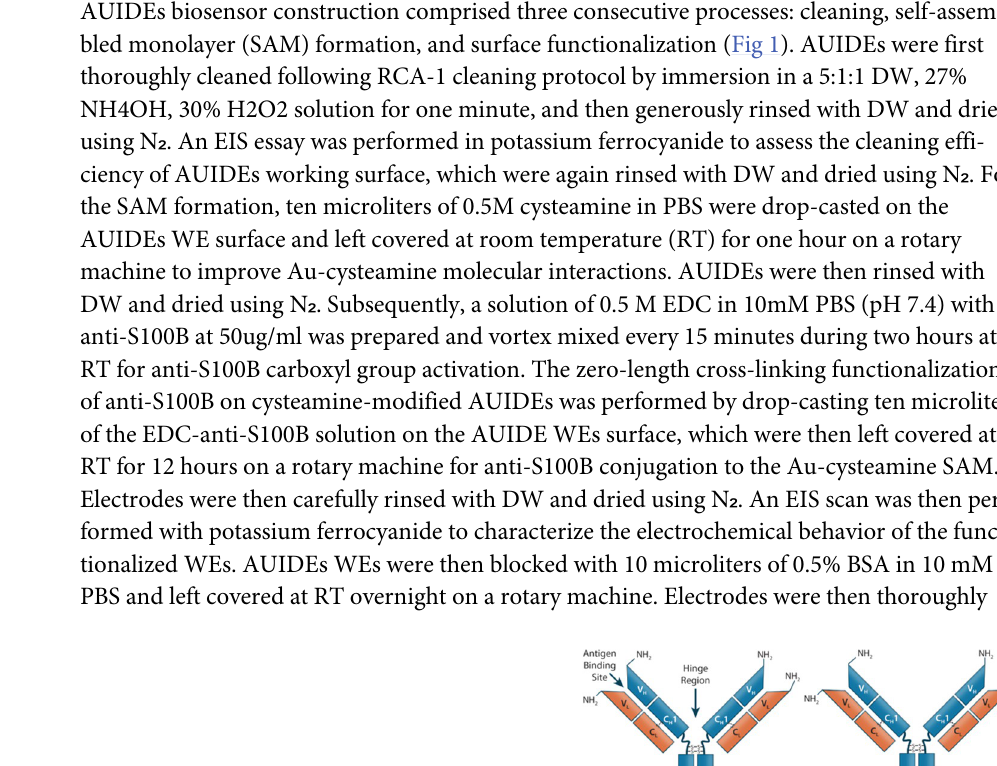
PLOS ONE | https://doi.org/10.1371/journal.pone.0263738 February 7,